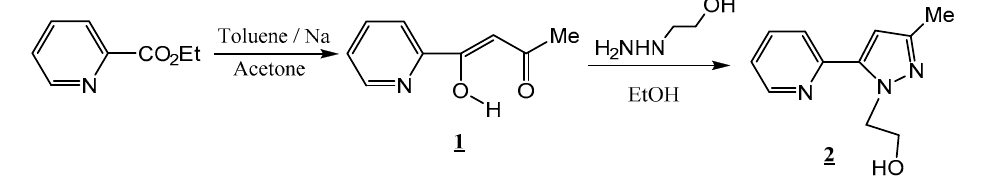
Table 1. Crystal data and refinement parameters for C 11 H 13 N 3